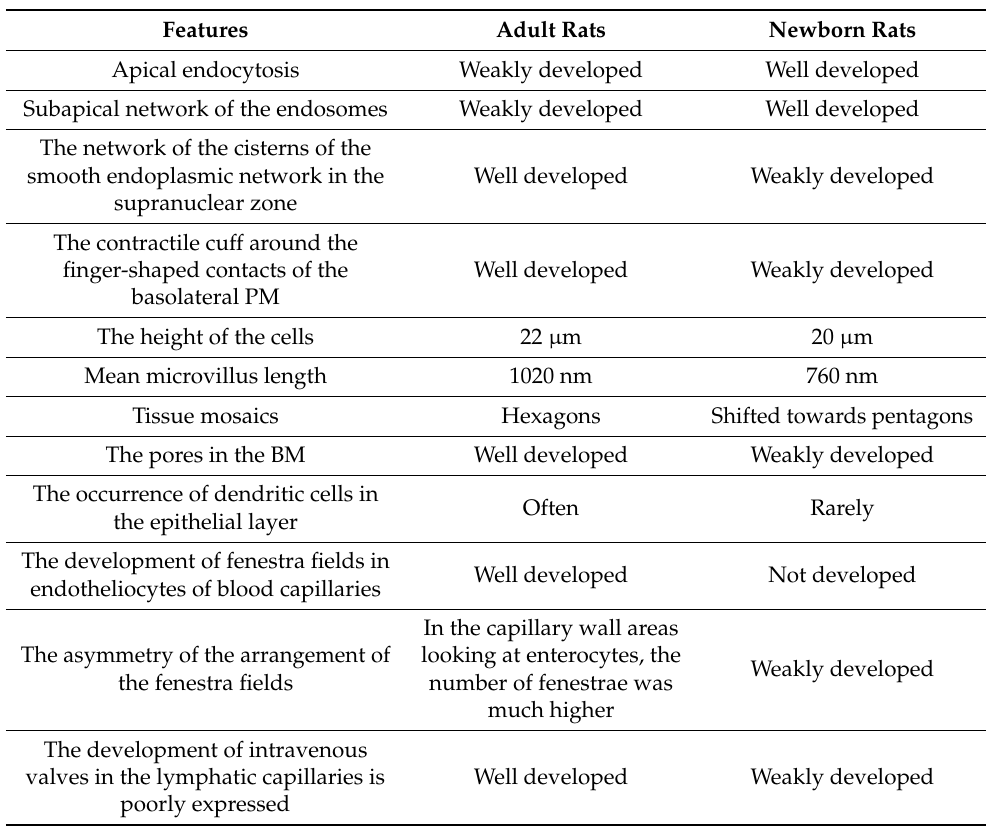
Well developed Weakly